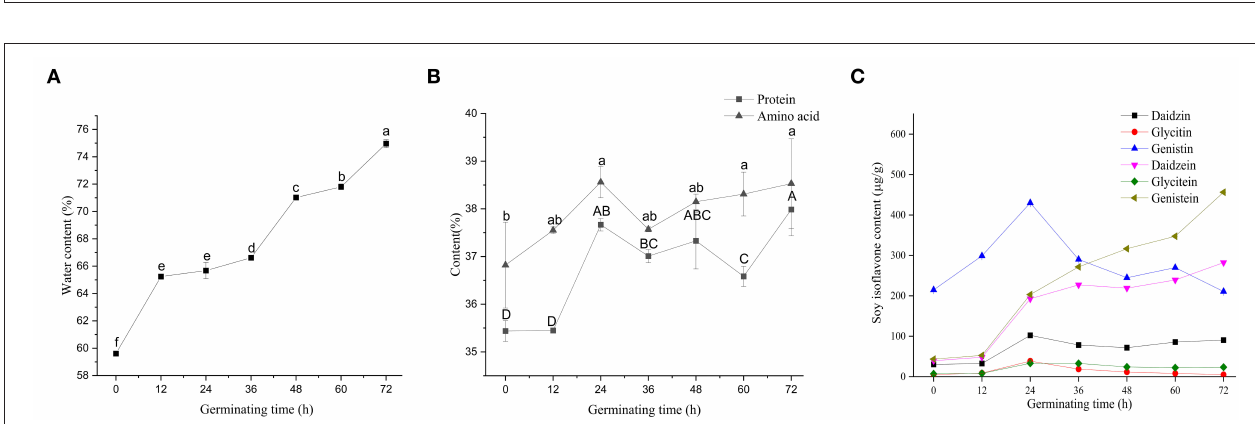
FIGURE 3 | Changes of nutrients in soybean with different germination times. Water content (A) , protein and amino acid contents (B) , and soy isoflavones contents (C) . All results are expressed as the mean ± SD. Differences were analyzed using the Duncan’s test. Groups without the same superscript letters were statistically different ( P <